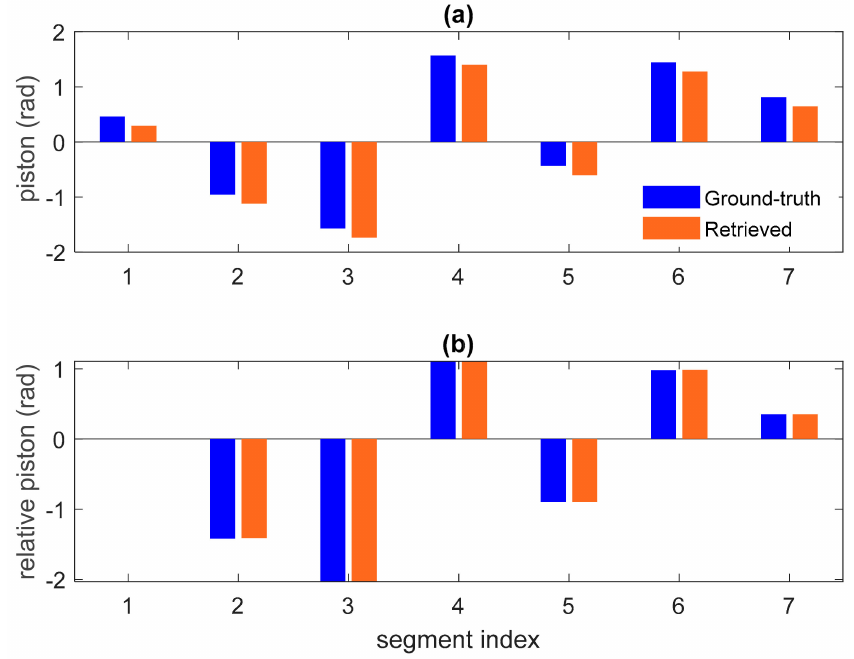
Figure 8. Small piston retrieval: ( a ) the retrieved piston vs. the ground truth piston and ( b ) the retrieved relative piston vs. the relative ground truth piston. In ( b ), the first segment is set as the reference.